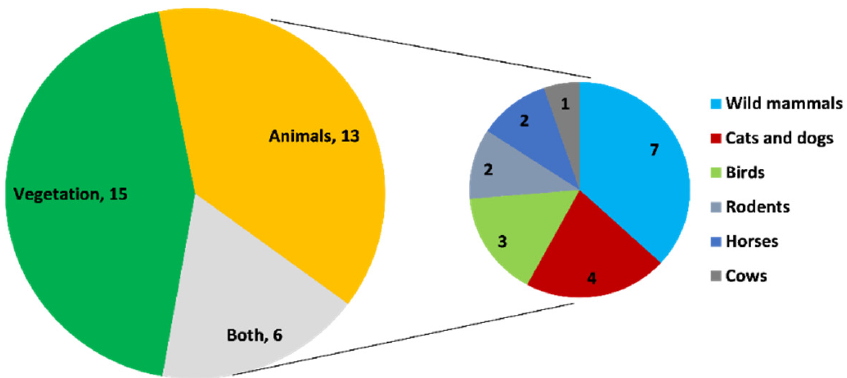
Figure 4. Number of studies on the basis of site of tick collection in Europe.